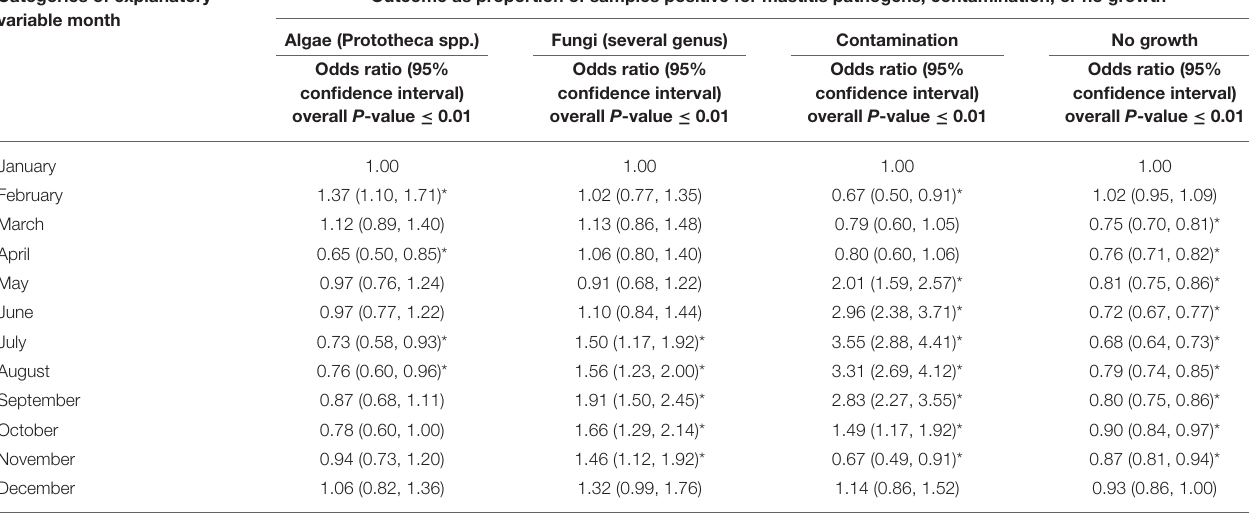
TABLE 8 | Regression analysis of the proportion of samples positive for mastitis pathogens, no growth, and contamination by month. Categories of explanatory Outcome as proportion of samples positive for mastitis pathogens, contamination, or no growth variable month Algae (Prototheca